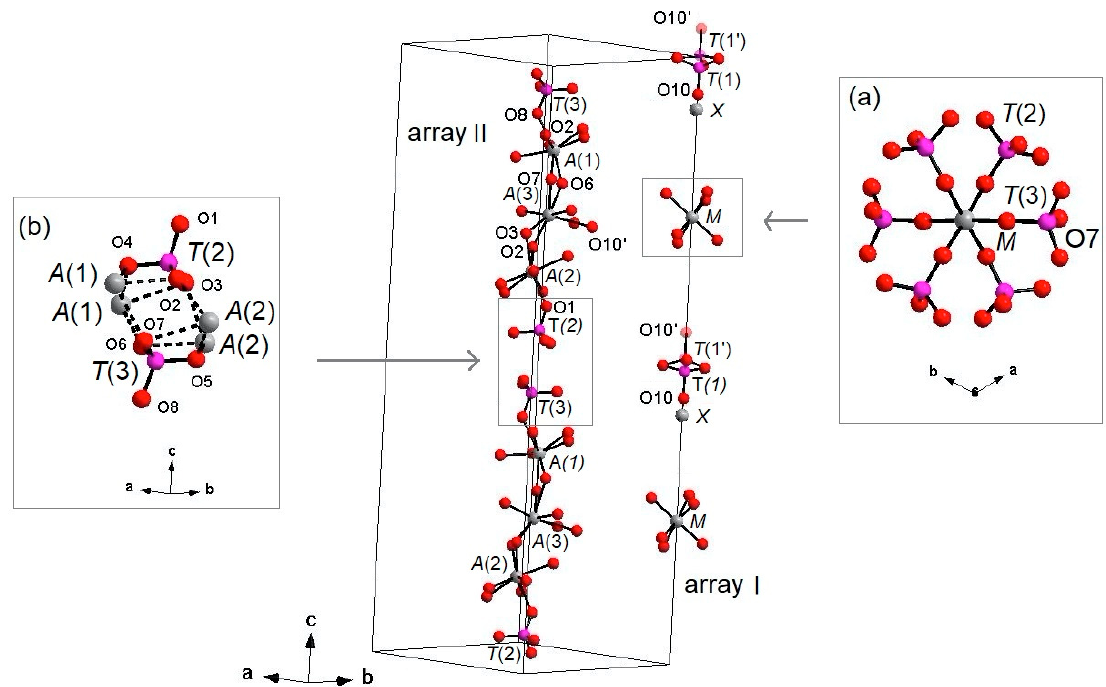
Figure 4. ‘I’ and ‘II’ arrays in whitlockite. Inset ( a ): [M(PO 4 ) 6 ] pinwheel units [32]. Inset ( b ): detail of II-II arrays joining ( M -O bonds dashed). H atoms omitted for clarity. X-O(1) bonds omitted for clarity.